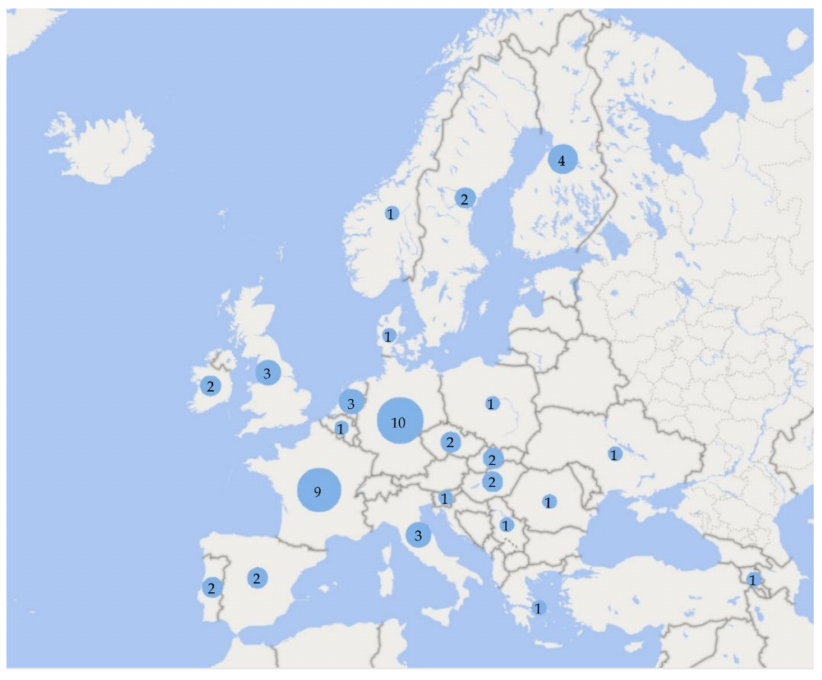
Figure 8. Remote sensing research conducted in Europe (number of publications shown by the query is indicated in the